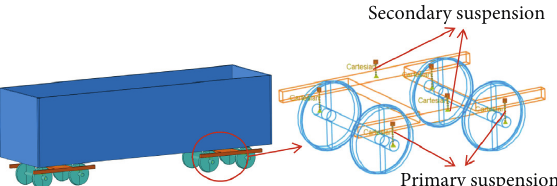
Figure 3: Numerical model of the heavy-haul freight